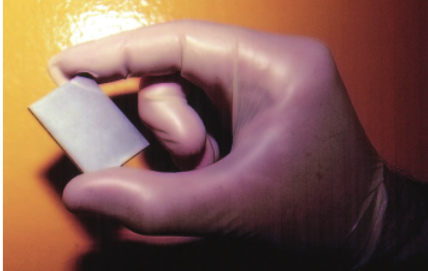
Figure 12: Surface view of the fuel rectangle.